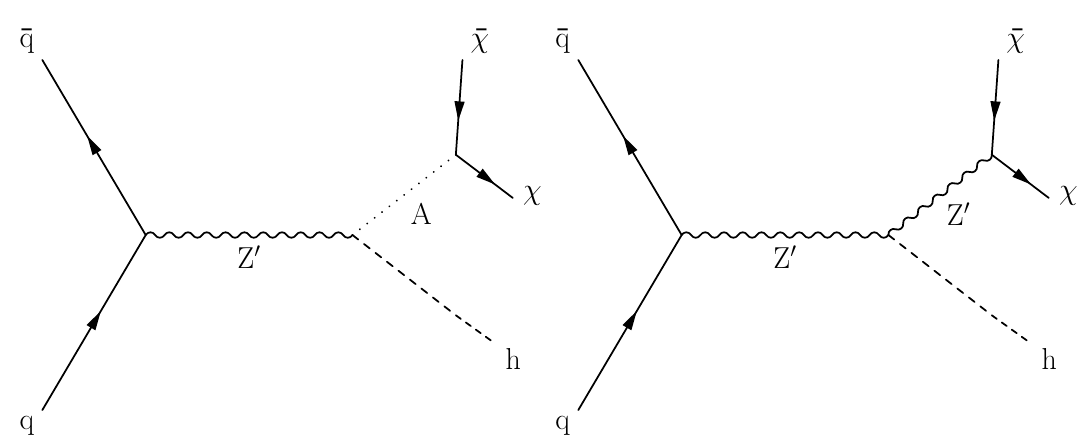
Figure 1 . Representative Feynman diagrams for the two benchmark signal models considered in this paper: the Z 0 -2HDM (left) and the baryonic Z 0 model (right). corresponding to a new baryon number U(1) symmetry. The Z 0 boson acts as a B